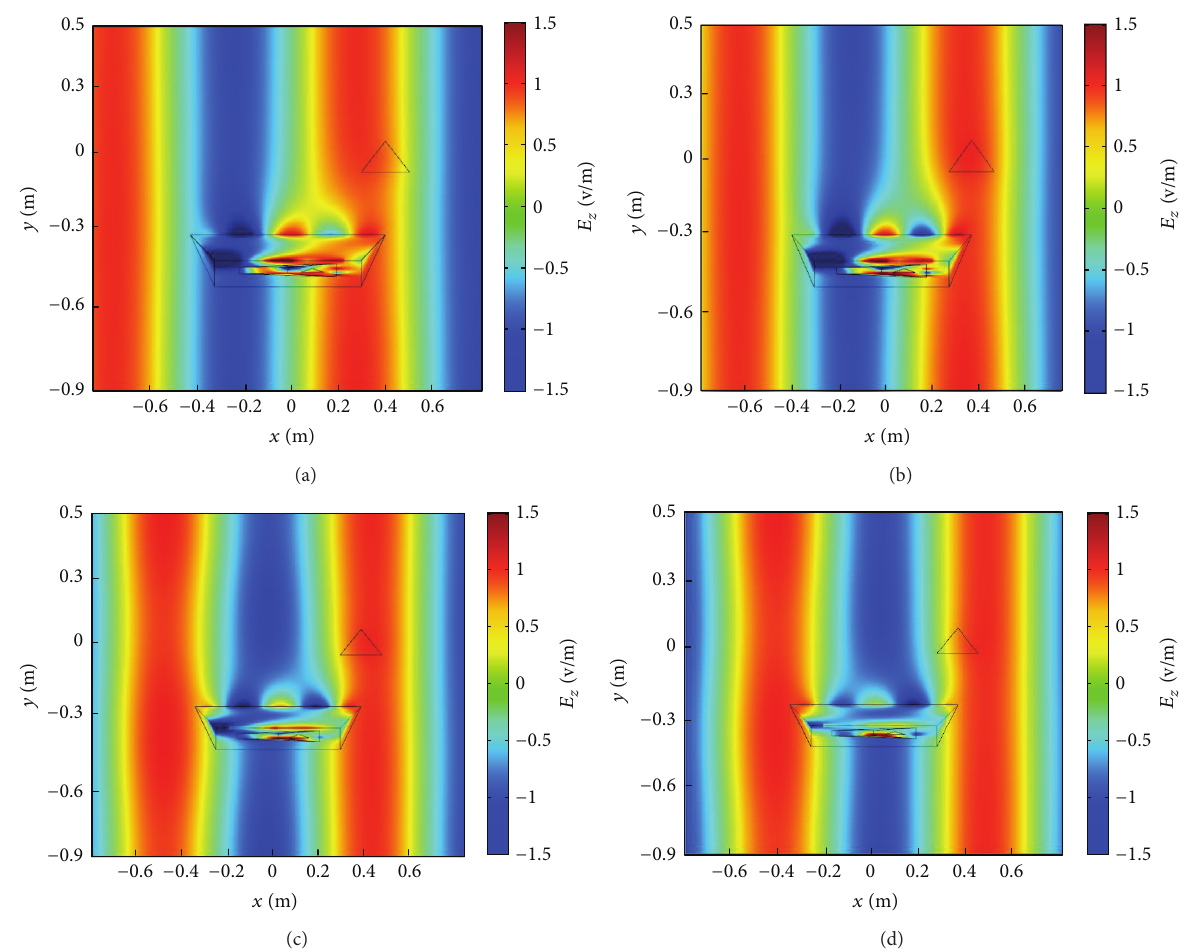
Figure 6: Electric field distributions of the trapezoid complementary illusion cloak for the incident plane waves with different initial phases: (a) 0 ∘ ; (b) 30 ∘ ; (c) 60 ∘ ; (d) 90 ∘